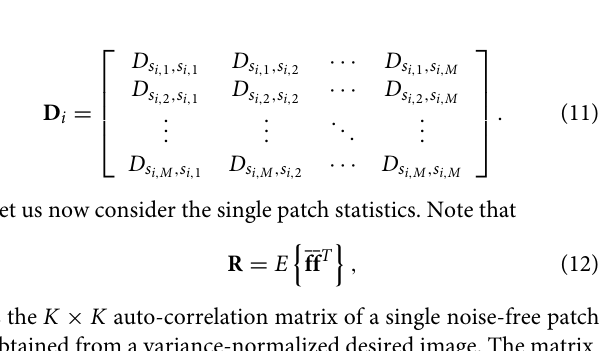
10 and the number of frames, P , varies from 1 to =